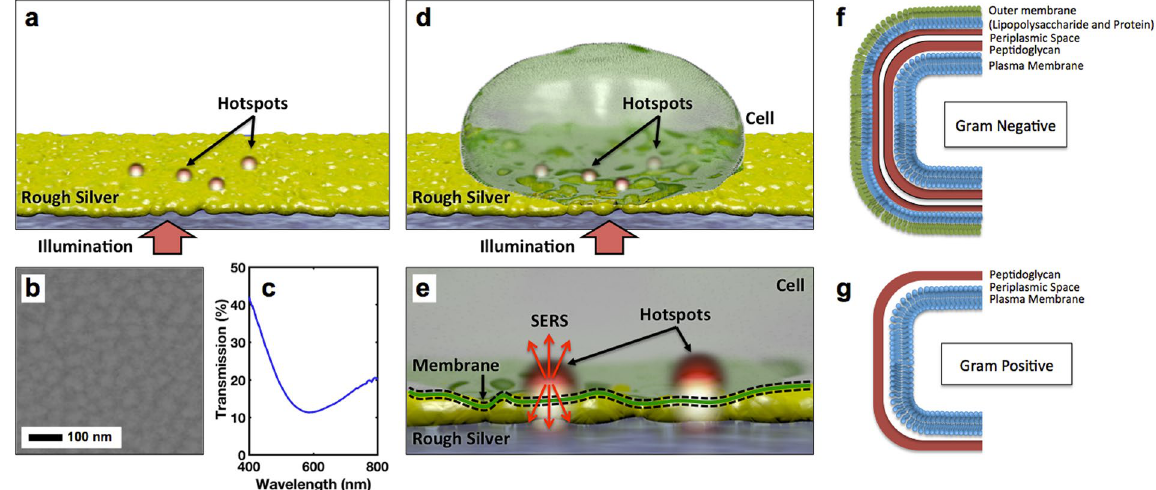
Figure 1. Illustration of imaging process and interaction between the plasmonic surface and the cell wall. ( a ) Depiction showing the creation of enhanced electromagnetic field “hotspots” due to illumination of the silver plasmonic surface from below. ( b ) SEM image of the plasmonic surface created by depositing 10 nm silver and a 2 nm chromium adhesion layer upon a glass microscope coverslip. ( c ) Transmission spectrum of an ultrathin silver island film showing a clear plasmonic resonance dip. ( d ) Depiction of a cell adsorbed to the rough plasmonic surface. ( e ) Schematic depicting the interaction between the hotspots and the cell wall. SERS is emitted from the sample and collected by the same objective used to illuminate from below. ( f ) Schematic depicting the molecular structure of a cell wall on a gram negative and ( g ) a gram positive bacterial species.